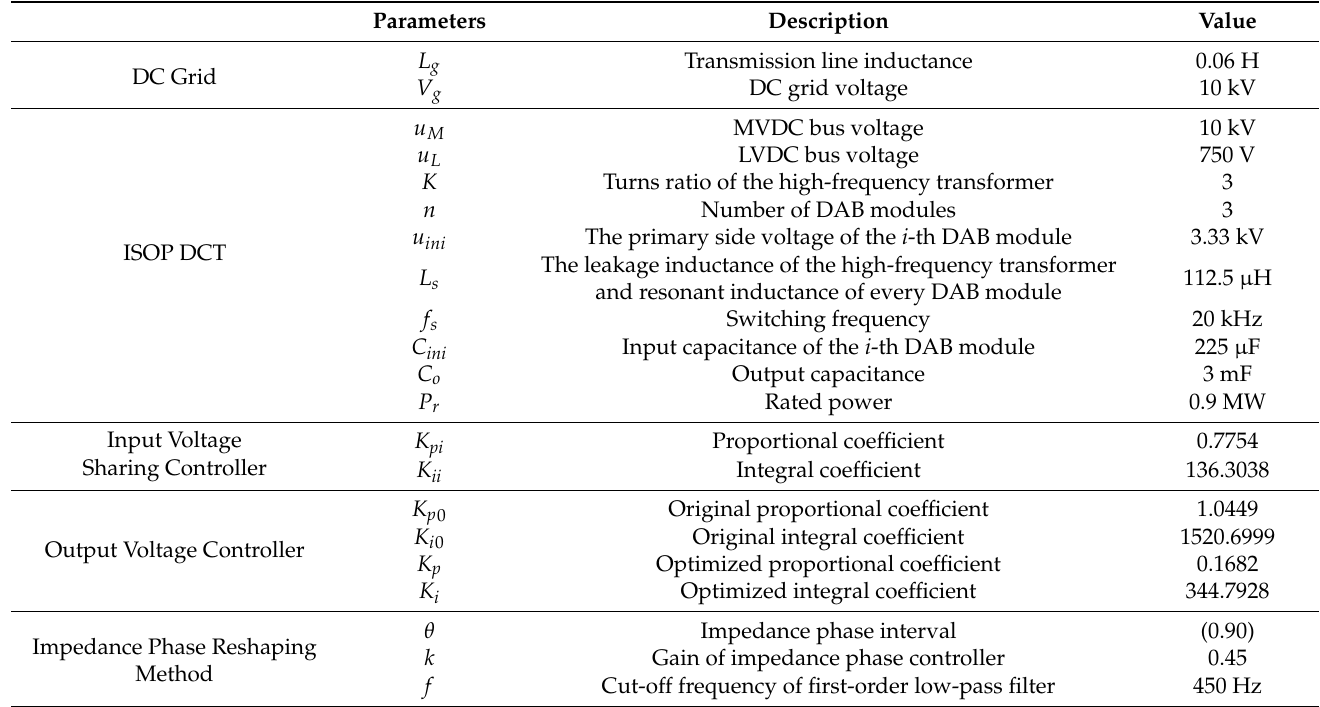
Table 1. Parameters of the MVDC distribution